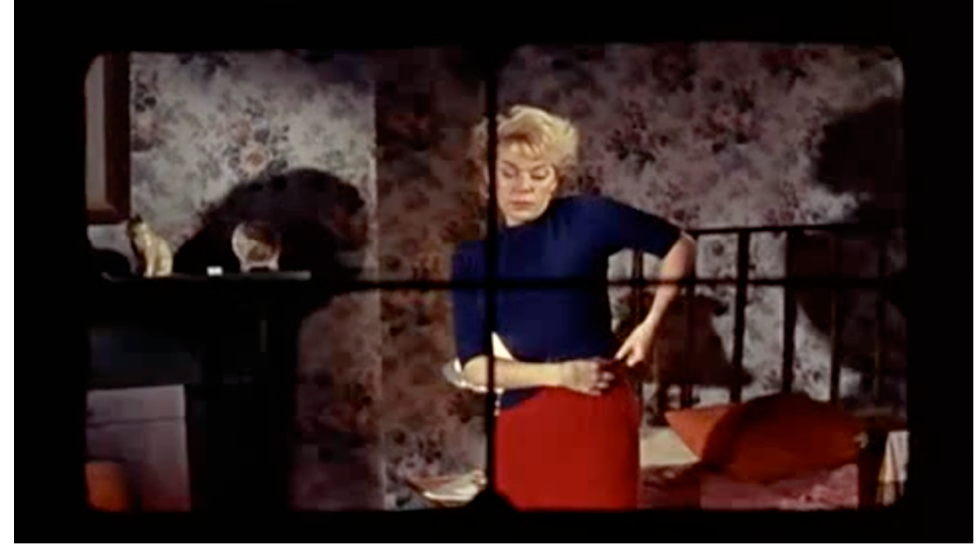
Figure 4. Image from Peeping Tom (1960) [25].